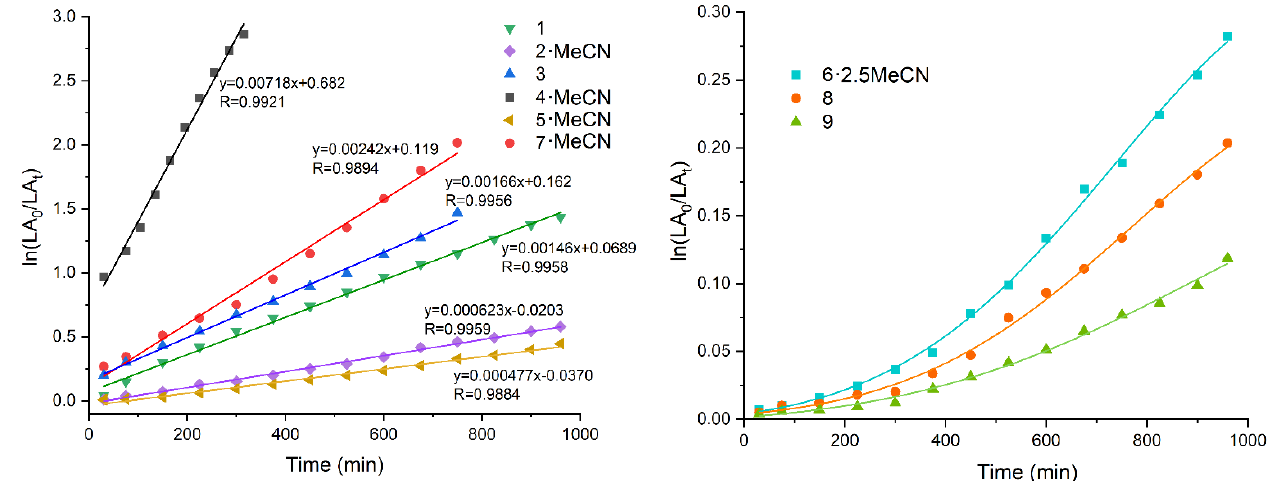
Figure 14. Semi-log plot of ln(LA 0 /LA t ) versus time for ROP using complexes 1 – 5 , 7 ( Left ), 6 and 8 – 9 ( Right ) (Table 3, entries 1–9). 1 H NMR spectroscopy analysis of the end groups of the PLA synthesized with com-